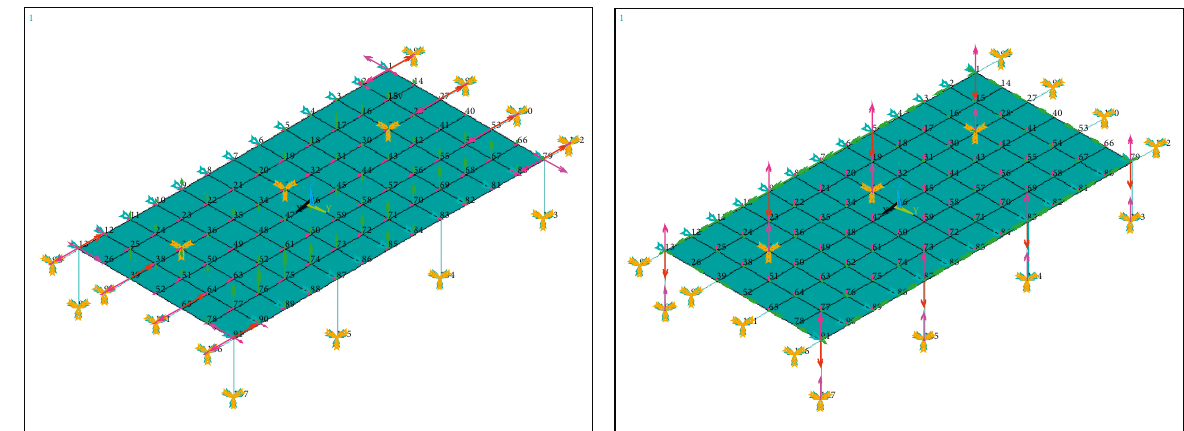
Figure 6: Finite element model of vibration isolation